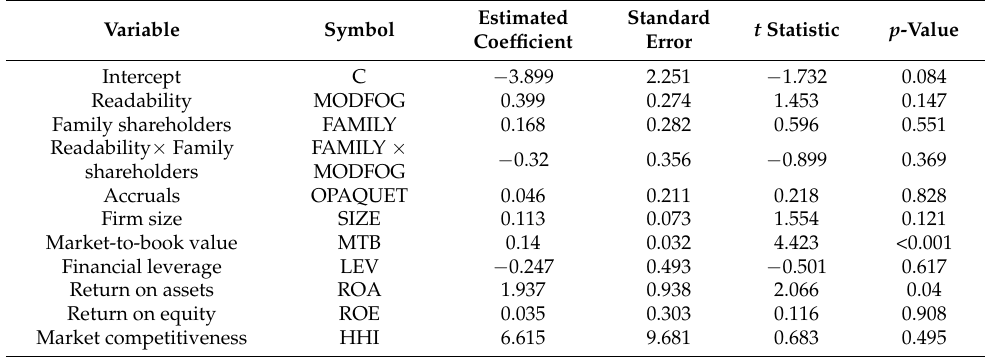
Table 13. Sensitivity analysis of the fourth